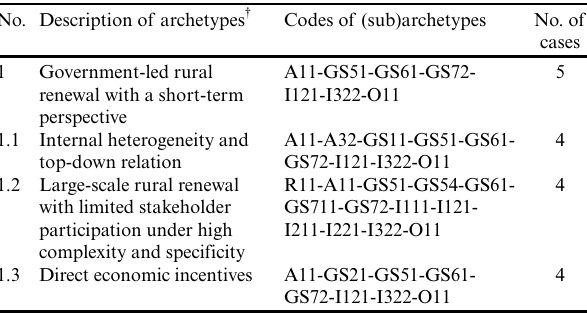
Table 2 . Archetypes for unsustainable rural